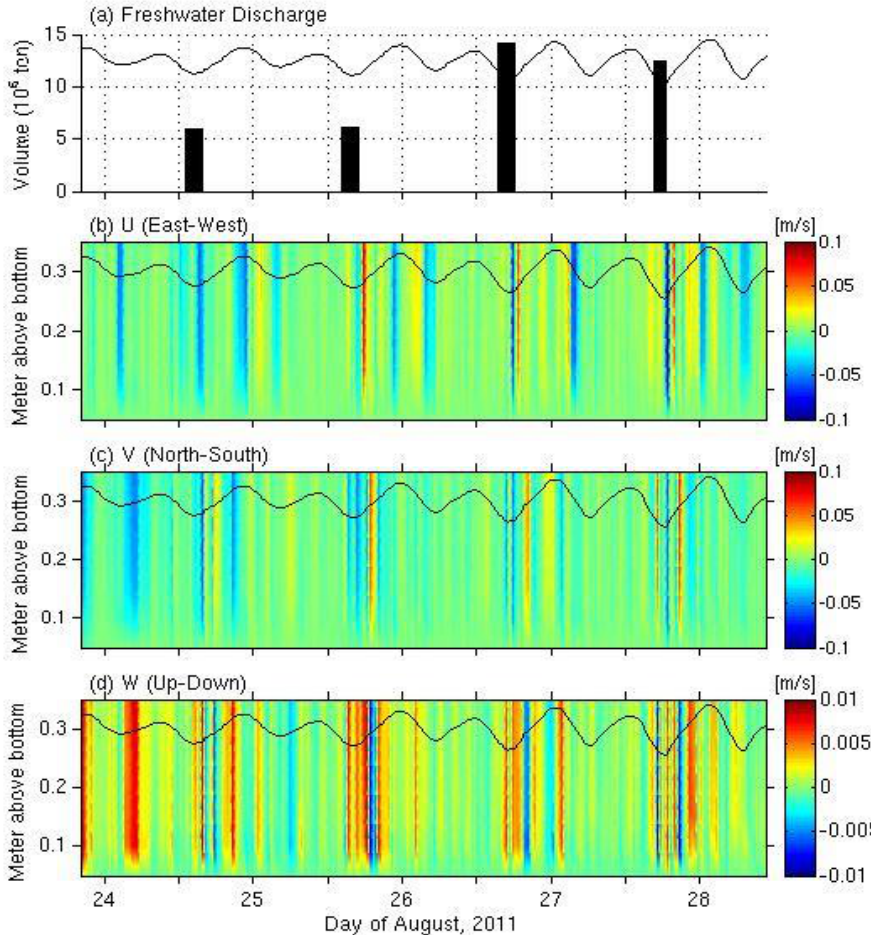
Figure 4. Time variation of the flow structure of the bottom boundary layer with freshwater discharge: ( a ) sea level and freshwater discharge, ( b ) east–west component, ( c ) north–south component, and ( d ) vertical component. The solid line in each panel indicates the sea surface level variation pattern and the scale was adjusted.